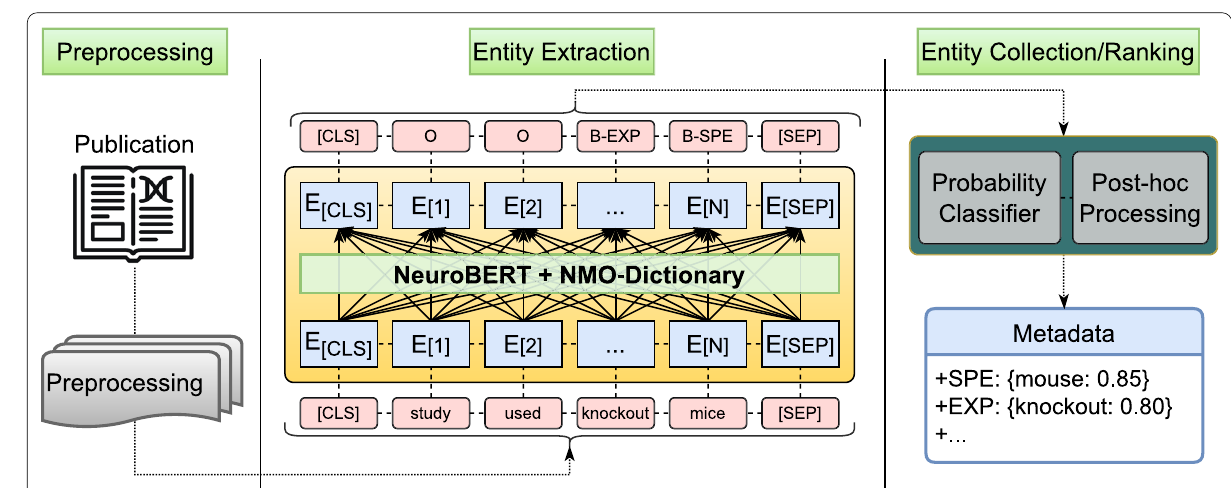
Fig. 3 Overview of the architecture of the metadata extraction system used in this study. The full text of the publication is preprocessed, marked with sentence boundaries (CLS and SEP), and converted into sequences of words. Each sequence is then passed through the entity extraction algorithm to identify occurrences of metadata entities. The candidate terms are then post-processed and ranked based on relevance